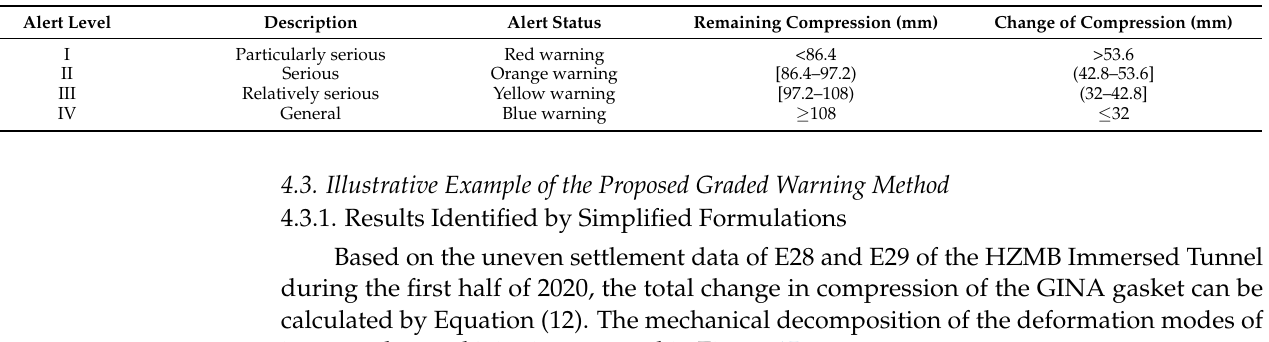
Table 6. The graded warning thresholds of the remaining compression of GINA gasket for the HZMB Immersed Tunnel.